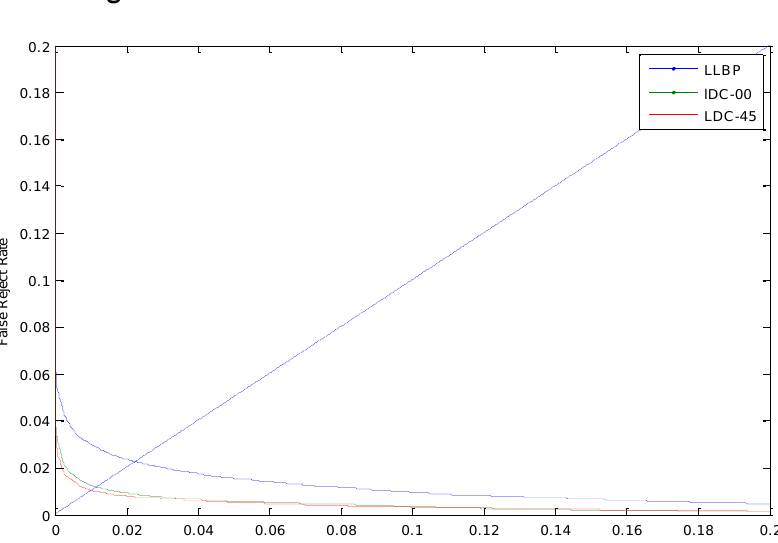
Figure 9. The ROC curve in the verification